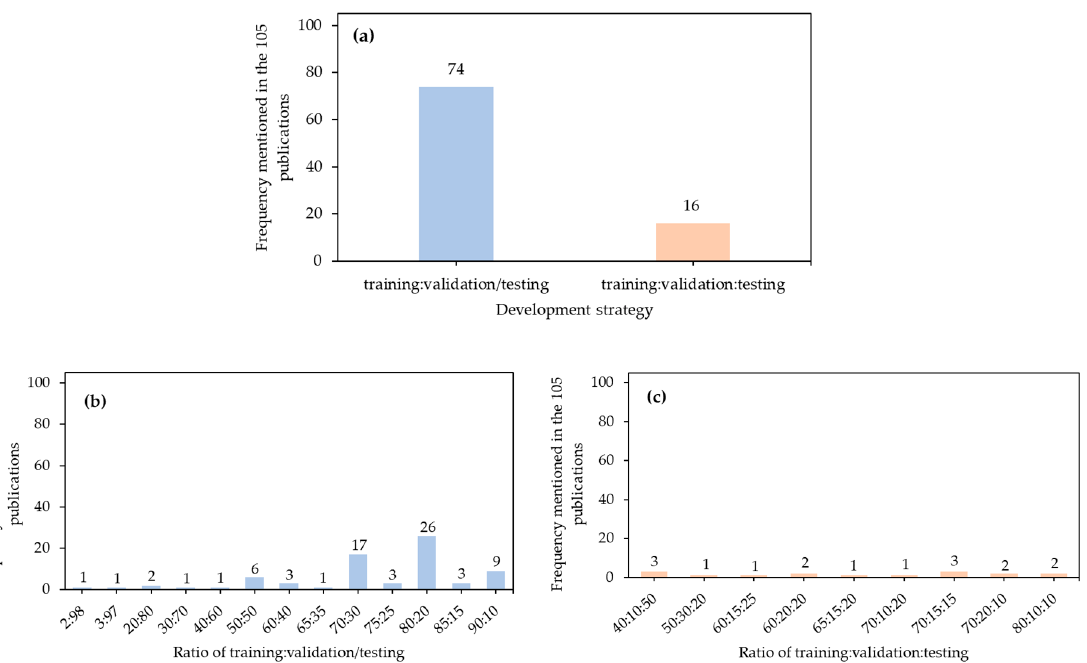
frequency of different ratios of training:validation/testing; and ( c ) frequency of different ratios of training:validation:testing.